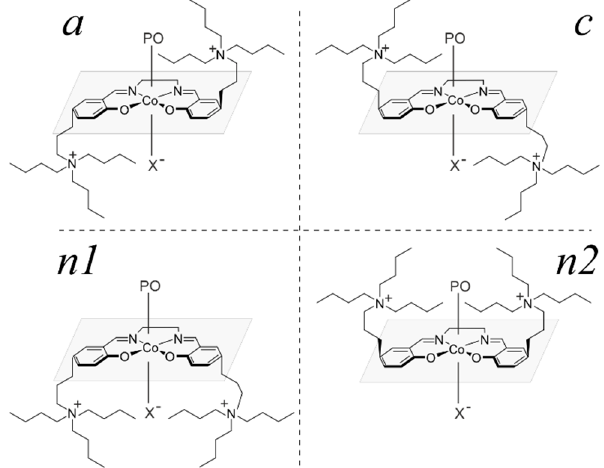
Figure 6. Schematic representation of stereoisomers resulting from spatial arrangement of cocatalyst units in organometallic cobalt complex with salen ‐ type ligand adopting trans configuration (see Appendix A). For clarity, only one X – , bound to the metal is shown.